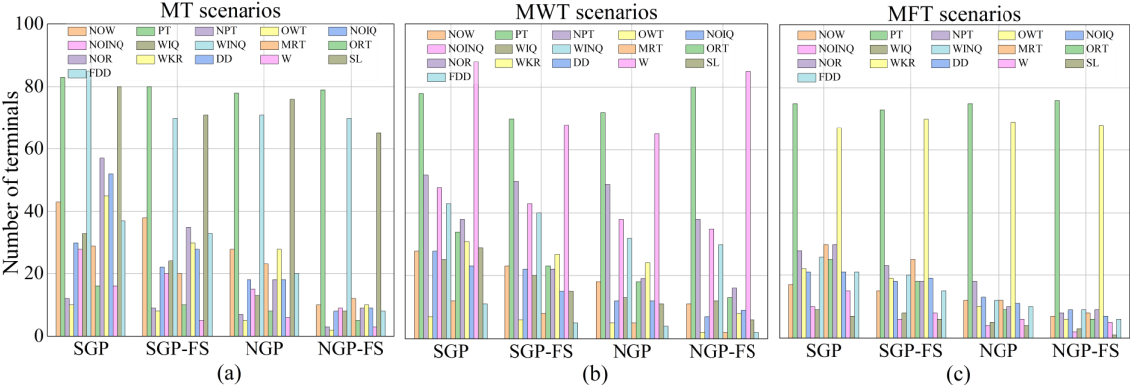
Figure 6. Terminal distribution in the 30 best-evolved rules for the SGP, SGP-FS, NGP, and NGP-FS algorithms for the three objectives. (a): Terminal distribution for the MT scenarios, (b): Terminal algorithms for the three objectives. ( a ): Terminal distribution for the MT scenarios, ( b ): Terminal distribution for the MWT scenarios, and (c): Terminal distribution for the MFT scenarios. distribution for the MWT scenarios, and ( c ): Terminal distribution for the MFT